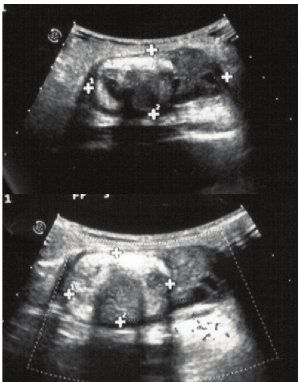
Figure 1: Preoperative US appearance of the inguinal mass, showing the herniated ovary and the teratoma.